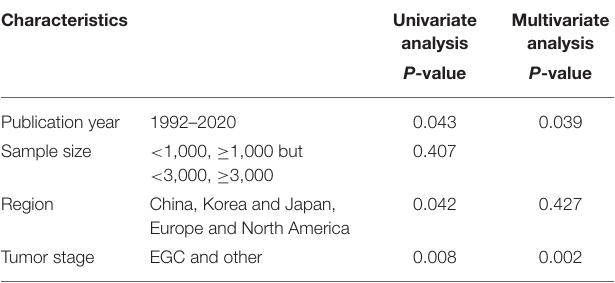
TABLE 4 | Meta-regression for all included